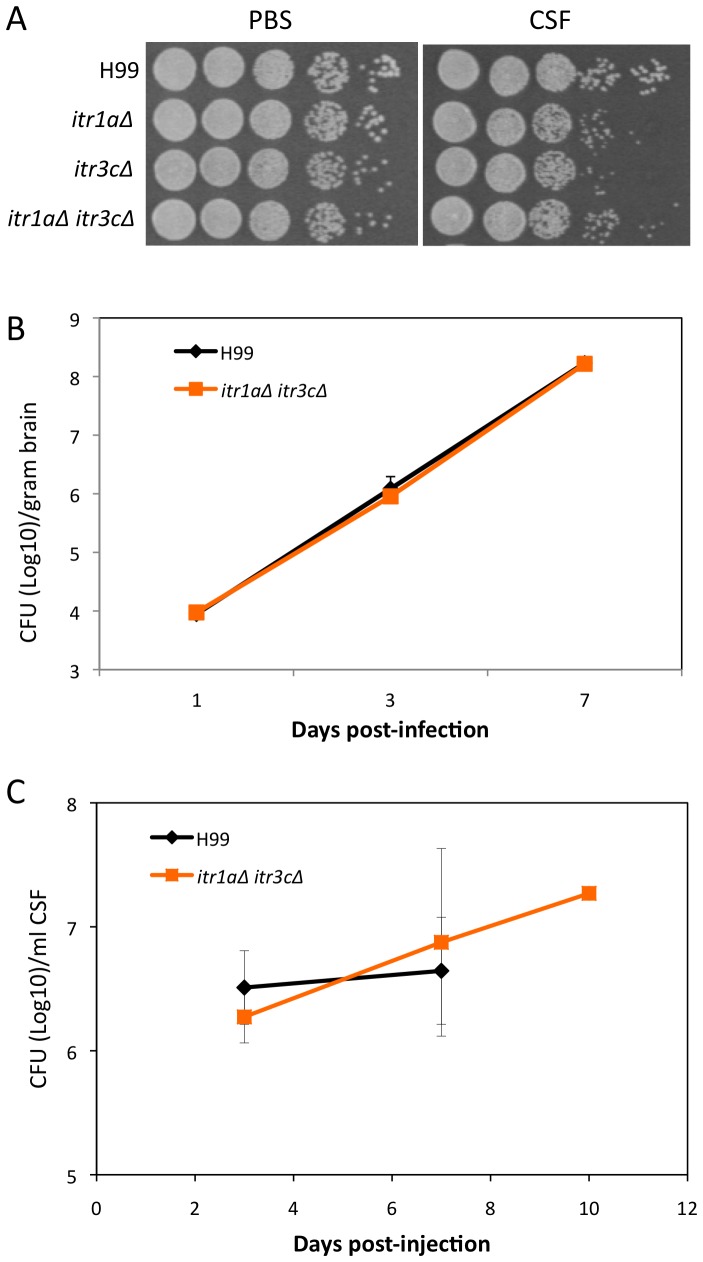
The itr1aΔ itr3cΔ double mutant does not exhibit a growth defect in cerebral spinal fluid (CSF).(A) Growth assays on plates using serial 10× dilutions were performed for H99, the itr1aΔ mutant, the itr3cΔ mutant, and the itr1aΔ itr3cΔ double mutant after treatment with either PBS buffer or purified human CSF. The results were photographed after 48 hr incubation. (B and C) Growth levels of H99 and the itr1aΔ itr3cΔ double mutant were compared by measuring the CFU of each strain isolated from total mouse brains (B) or CSF of rabbits (C) over time. Mice and Rabbits were infected intrathecally with 500 CFU and 108 CFU of each strain, respectively. Fungal burden in infected mice were assess 1, 3, and 7 days post-inoculation, while fungal burden in rabbits was assessed 3, 7, and 10 days post-inoculation. The CFU data (10 days) for H99-infected rabbits was not shown since all three rabbits were dead less than 10 days post-infection. Error bars indicate standard deviations.